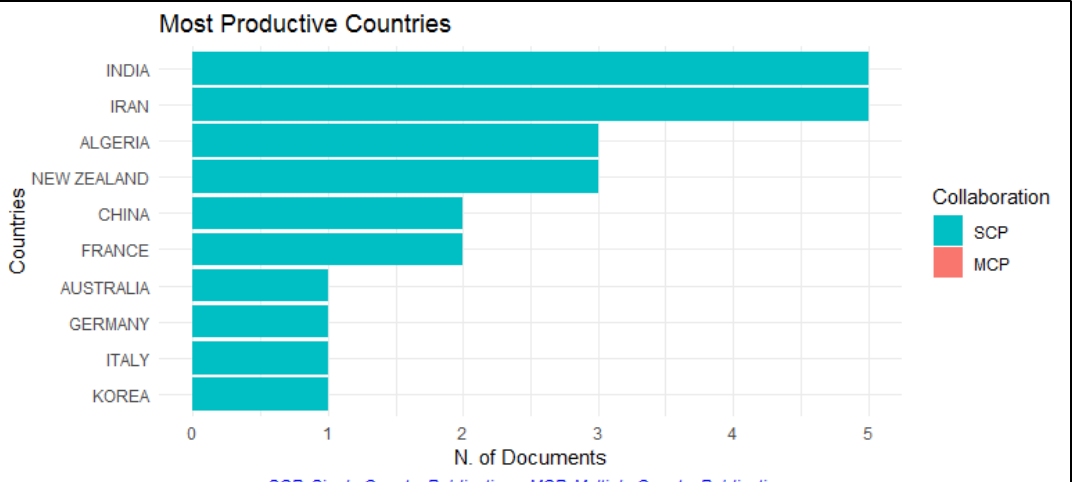
Figure 5. Most productive countries.